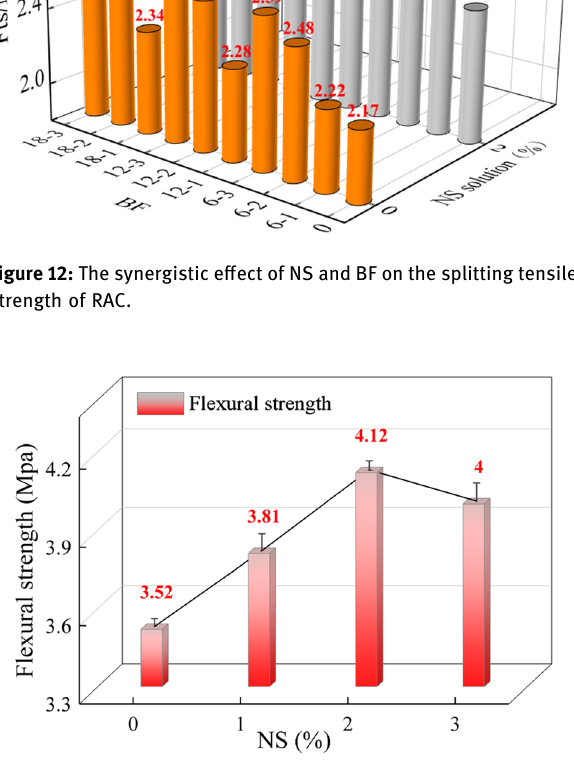
Figure 13: E ff ect of NS concentration on the fl exural strength of RAC.